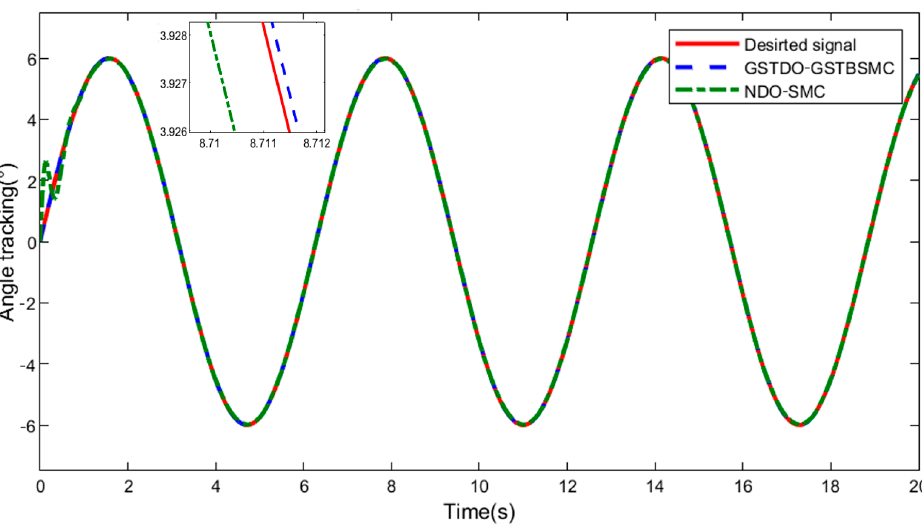
Figure 10. Comparison of the tracking results of GSTDO-GSTBSMC and NDO-SMC in Experiment 2.